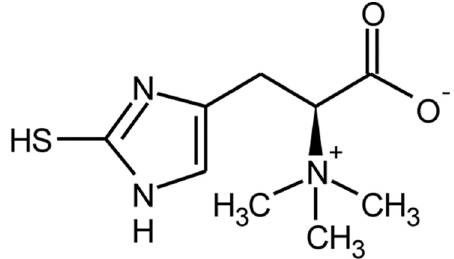
Figure 2. Chemical structure of ergothioneine.